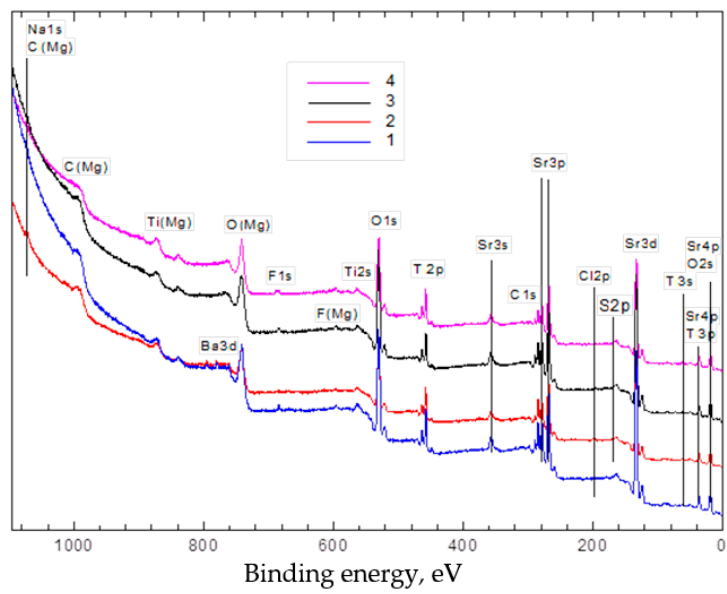
Figure 10. XPS survey spectra. 1—MA-1, 2—MA-2, 3—MA-3, 4—MA-4. F1s is from the set-up pumping system.